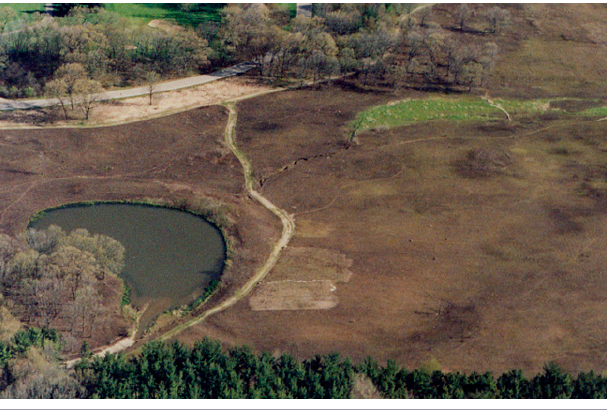
Fig. 6. Aerial photo showing the stormwater pond and a 2000 m² patch of invasive reed canary grass downstream of the pond outflow, within vegetation that was burned in central Curtis Prairie, University of Wisconsin-Madison Arboretum. Photo: J. B.